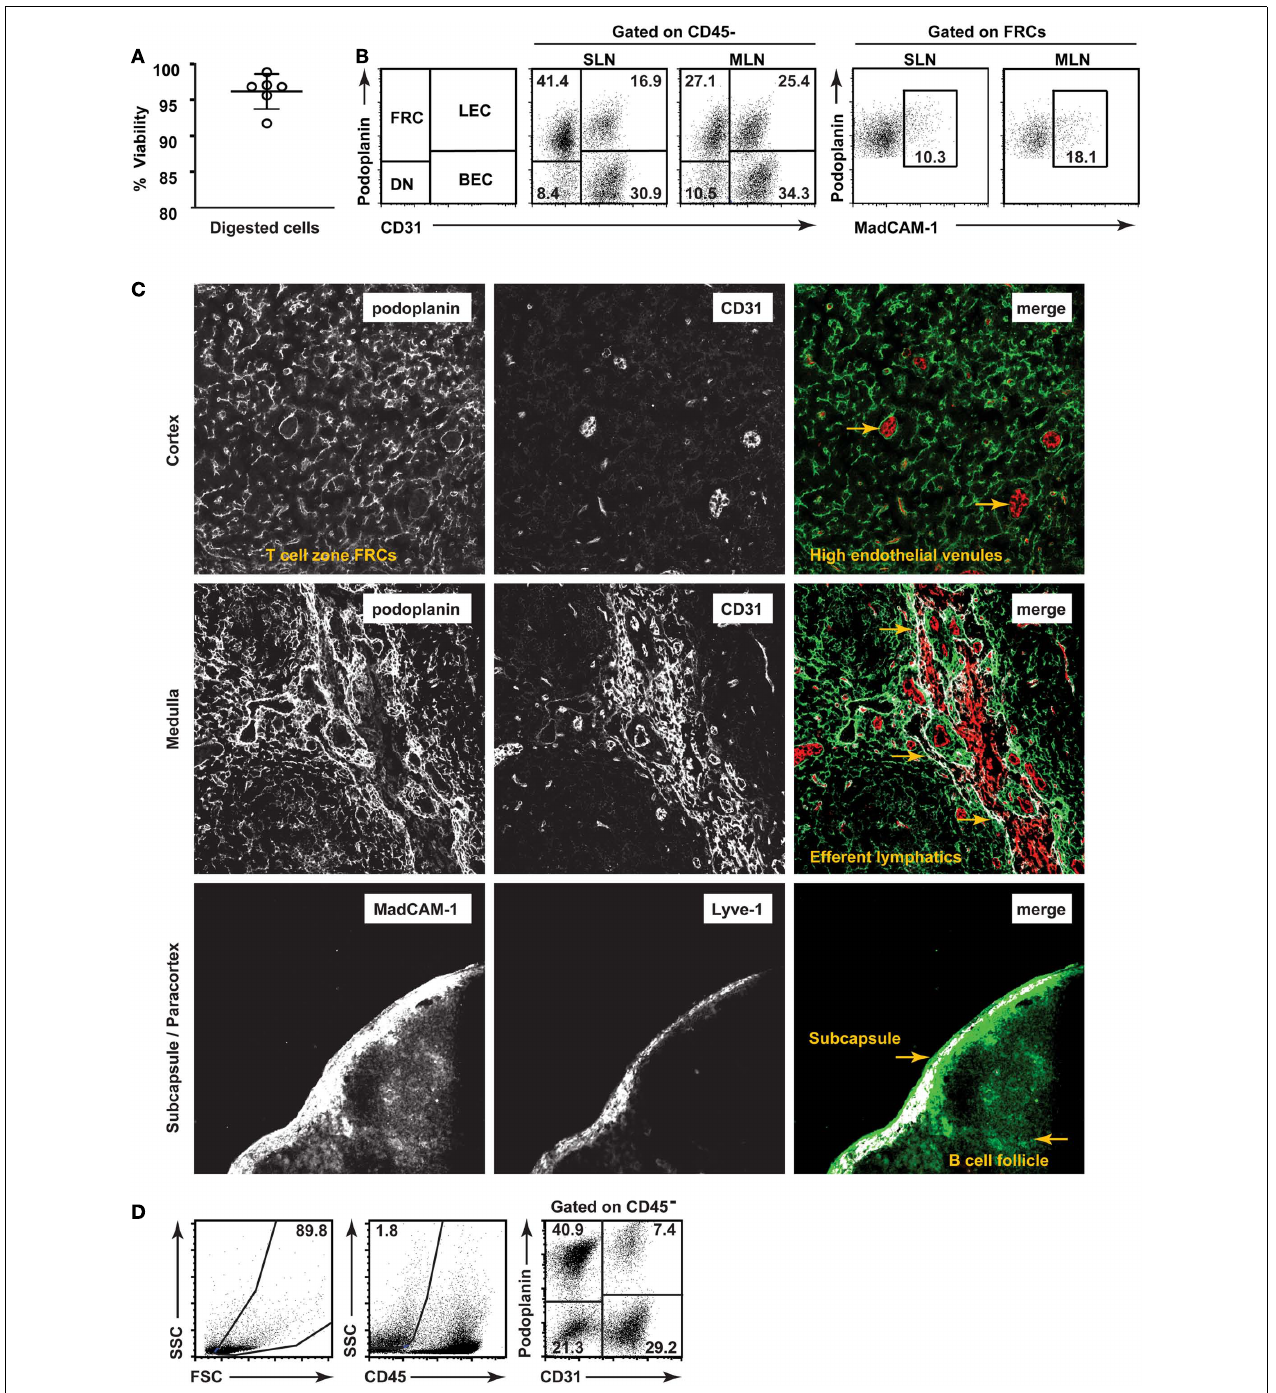
FIGURE 2 |Validation of a low-mortality method for isolation of lymph node stromal subsets. (A) Viability of single cell suspensions prepared using a low-mortality enzymatic digestion method. n = 6, mean + SD. (B) Typical flow cytometric profiles of lymph node stromal subsets freshly isolated from skin-draining or mesenteric lymph nodes of individual mice. (C) Lymph node stromal subsets identified in situ on cryosections.Top panel:T cell zone FRCs (podoplanin + CD31 − ) and high endothelial venules (podoplanin − CD31 + with cuboidal morphology).Two examples of HEVs are designated using arrows.